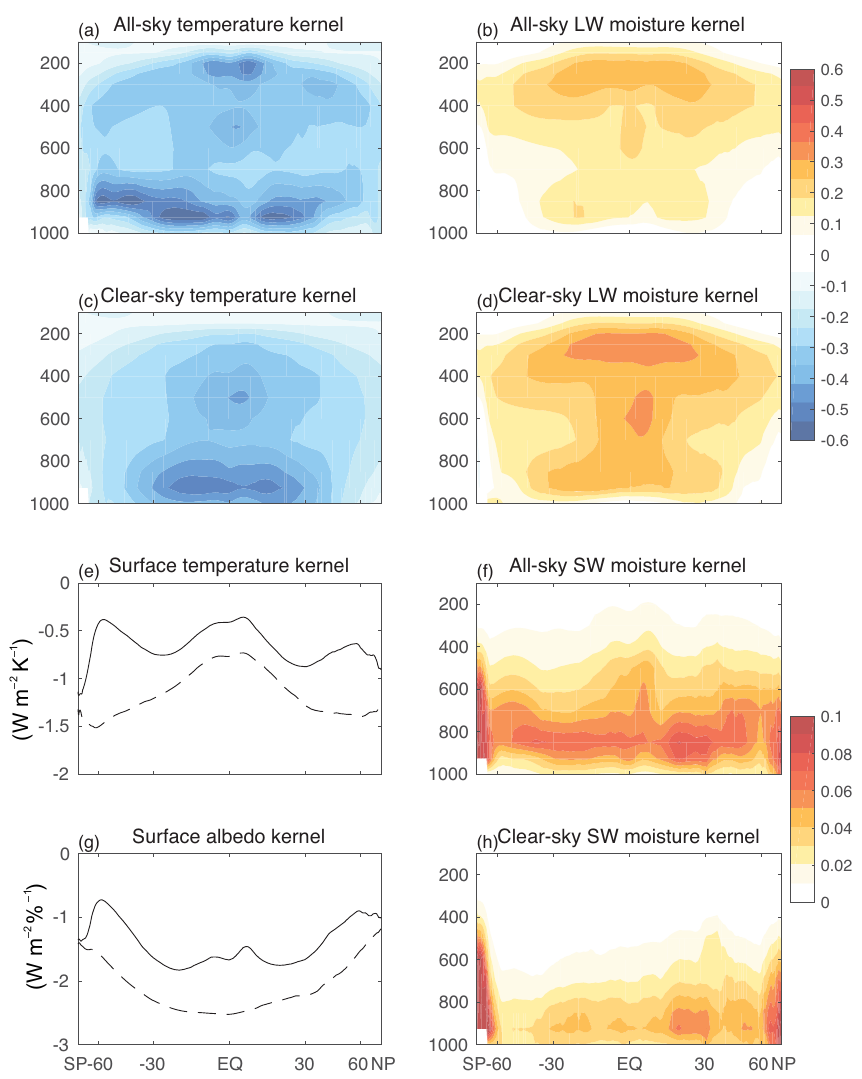
Figure 1. Top-of-atmosphere kernels from CESM1(CAM5). Zonal, annual-mean temperature, longwave moisture, and shortwave moisture kernels for all-sky and clear-sky. In panels (e) and (g) all-sky kernels are shown in solid lines and clear-sky kernels in dashed lines. The sign convention is positive